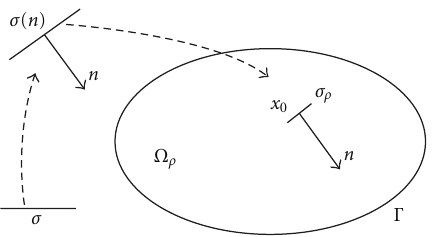
Figure 1: Example of domain and inserted crack (with its orienta-